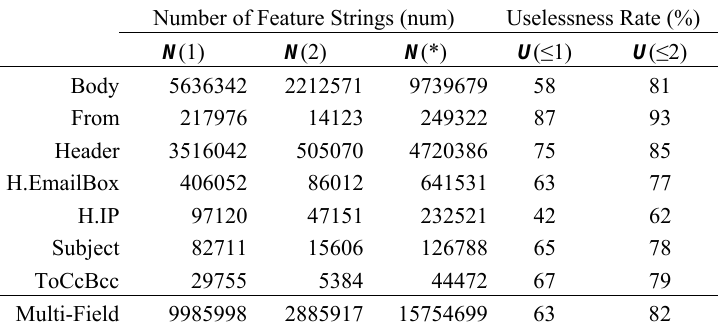
Table 3. Number of Feature Strings and Uselessness